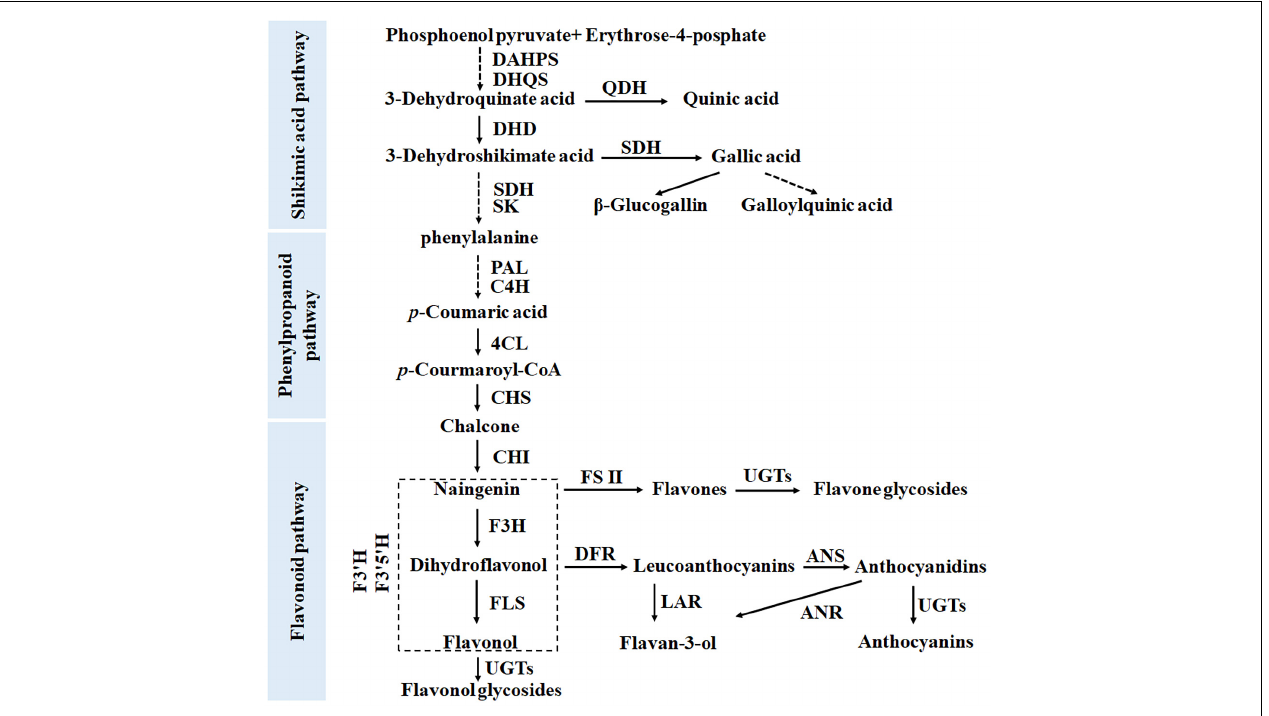
FIGURE 1 | Biosynthetic pathway of phenolic compounds in tea plants, including the shikimate, phenylpropanoid, and flavonoid